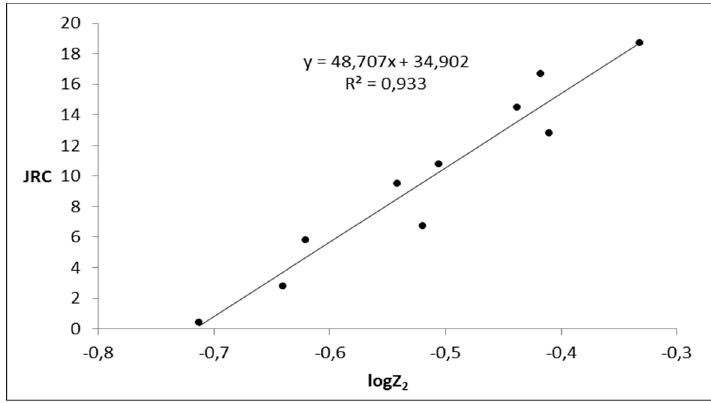
Figure 1. JRC-logZ 2 relationship for the ten standard JRC profiles of Barton and Choubey [4].